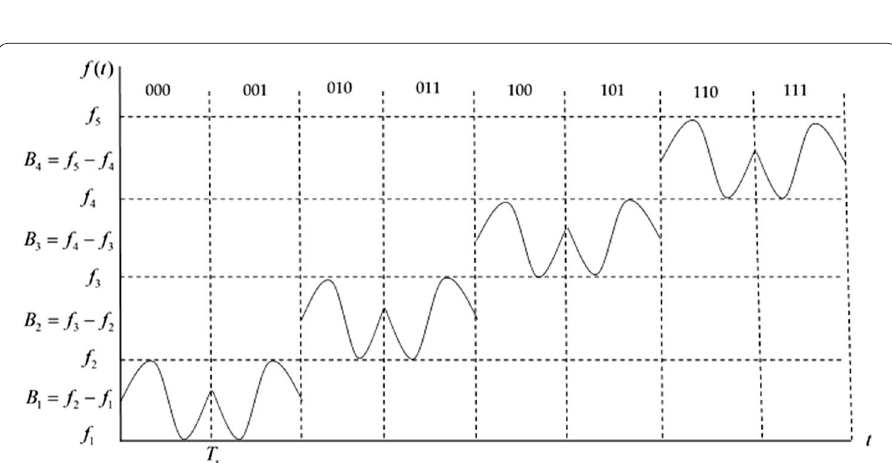
Fig. 6 Time–frequency representation of M-ary sine chirp spread